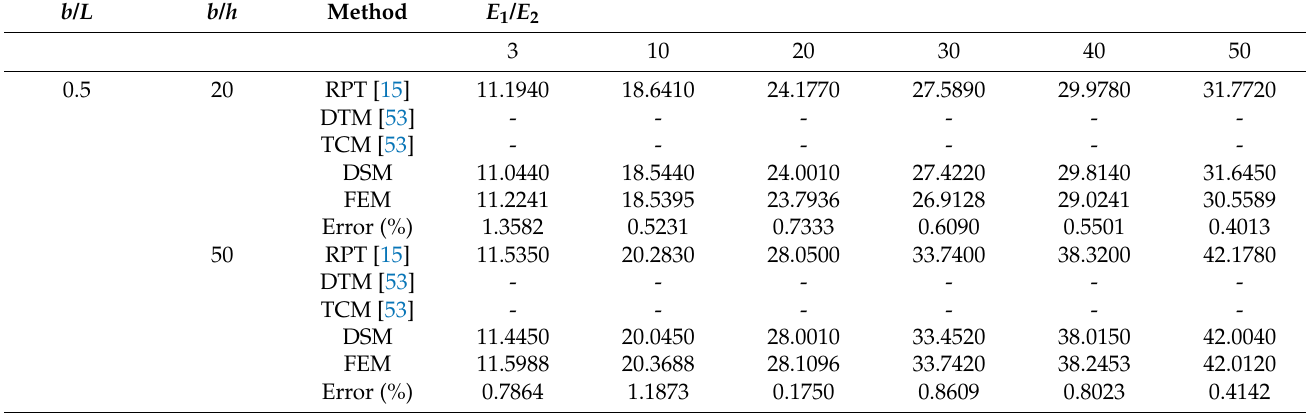
Table 6. Comparison of the fundamental frequency parameters plate with the CC boundary